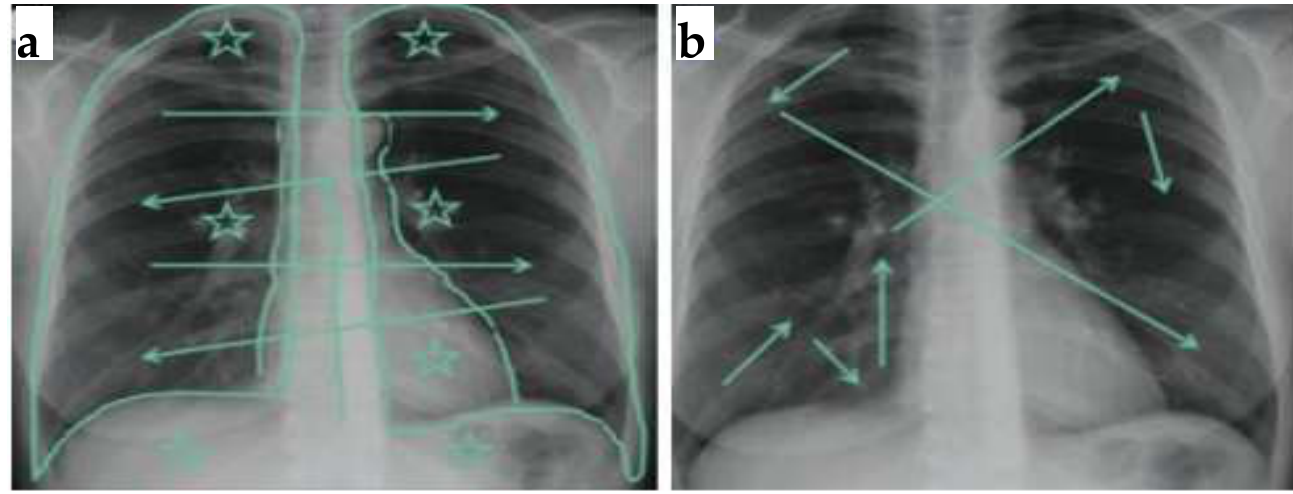
Figure 1. Multiple chest X-ray scanning routes ( a ); depiction of all scanning zones in symmetry ( b ). X-ray and CT Scan images of the same patient are presented in Figure 2, where image (a) is an X-rays that show no nodule, while CT scan images (b,c) identify the lung cancer nodules.